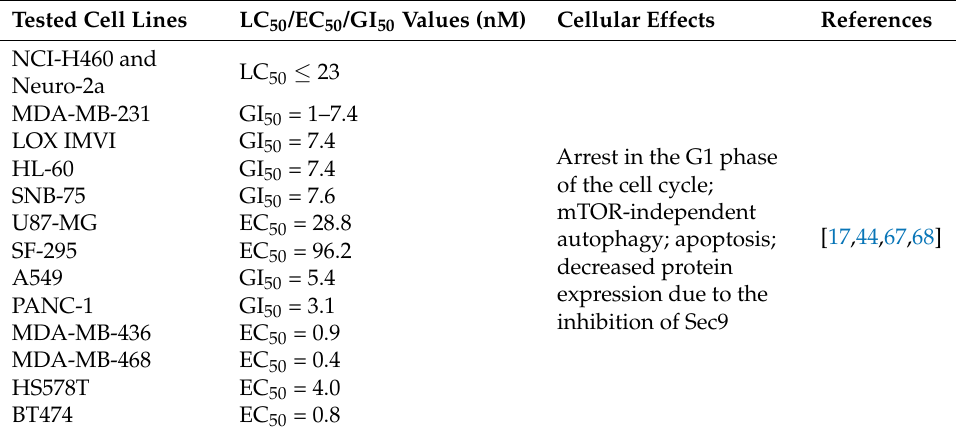
Table 6. Coibamide A activity on cancer cell lines. Tested Cell Lines LC 50 /EC 50 /GI 50 Values (nM) Cellular